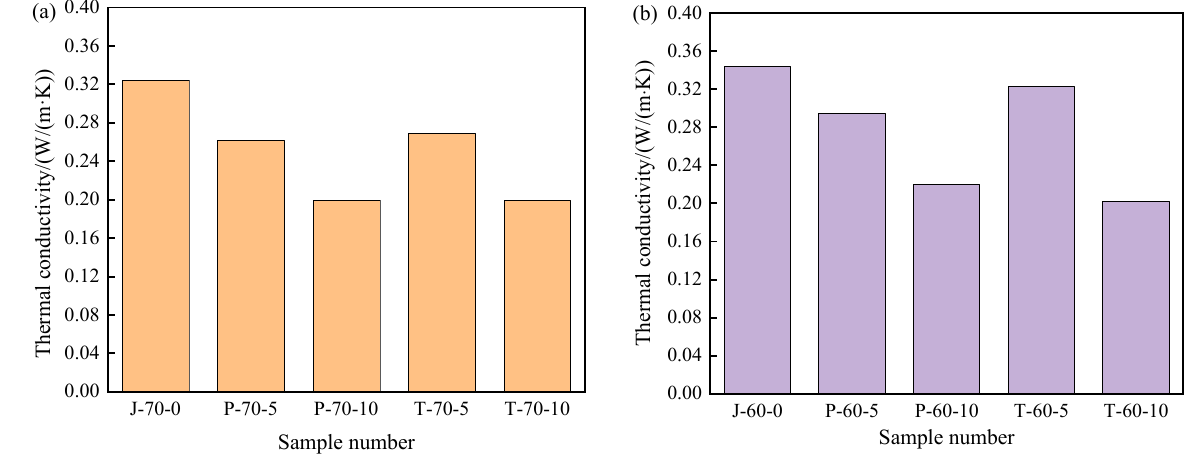
Figure 11. Thermal conductivity of recycled aggregate pavement bricks containing PEG-400/SiO 2 and Tet/SiO 2 composite shaped PCM: ( a ) 70% brick slag; ( b ) 60% brick slag.